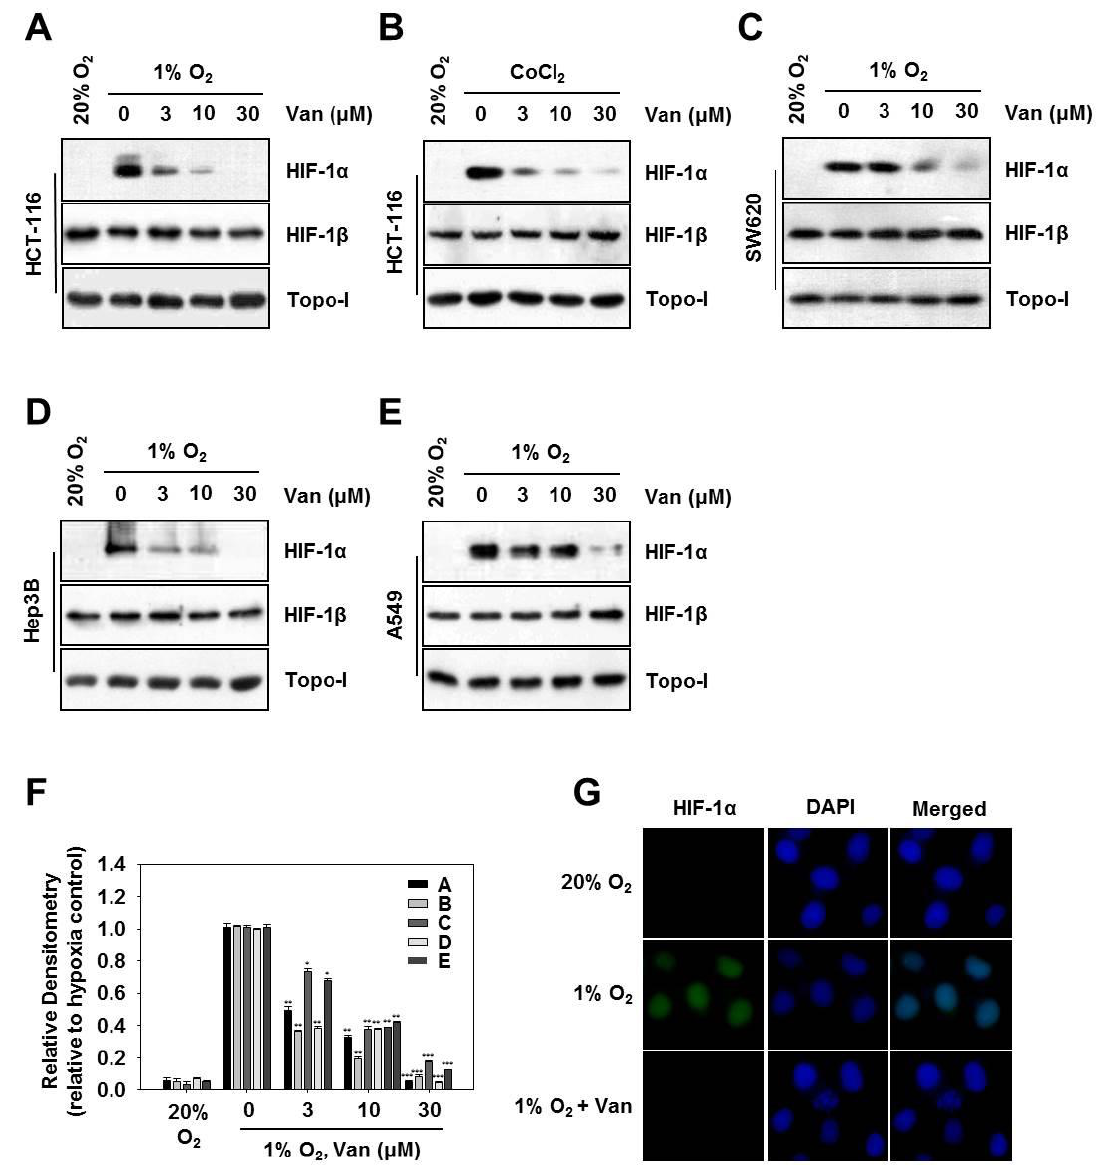
Figure 2. Vanillic acid (Van) inhibits HIF-1 α protein expression in a dose-dependent manner. ( A , C – E ) HCT116, SW620 cells, Hep3B, and A549 cells were pretreated without or with indicated concentration of vanillic acid (Van), then cultured under normoxic or hypoxic conditions for 12 h. Whole-cell lysates for HIF-1 β and nuclear extract for HIF-1 α were detected by Western blot. Anti-Topo-I antibody was used as a loading control. ( B ) HCT116 cells were cultured with the indicated concentration of vanillic acid (Van) for 30 min and treated with CoCl 2 (200 µ M). After 12 h incubation, the whole-cell lysates for HIF-1 β and nuclear extract for HIF-1 α was detected by Western blot. Anti-Topo-I antibody was used as a loading control. ( F ) Data were shown as mean ± SD ( n = 3). * p < 0.05, ** p < 0.01, *** p < 0.001, compared with hypoxia control. ( G ) HCT116 cells cultured in chamber slides, then were treated with or without vanillic acid (Van, 30 µ M) under normoxic or hypoxic conditions for 12 h. The left column shows the HIF-1 α protein in green fluorescence. The middle column shows nuclei stained with 4 (cid:48) ,6-diamidino-2-phenylindole (DAPI, blue fluorescence). The right column shows the merged images. Magnification = 400 ×